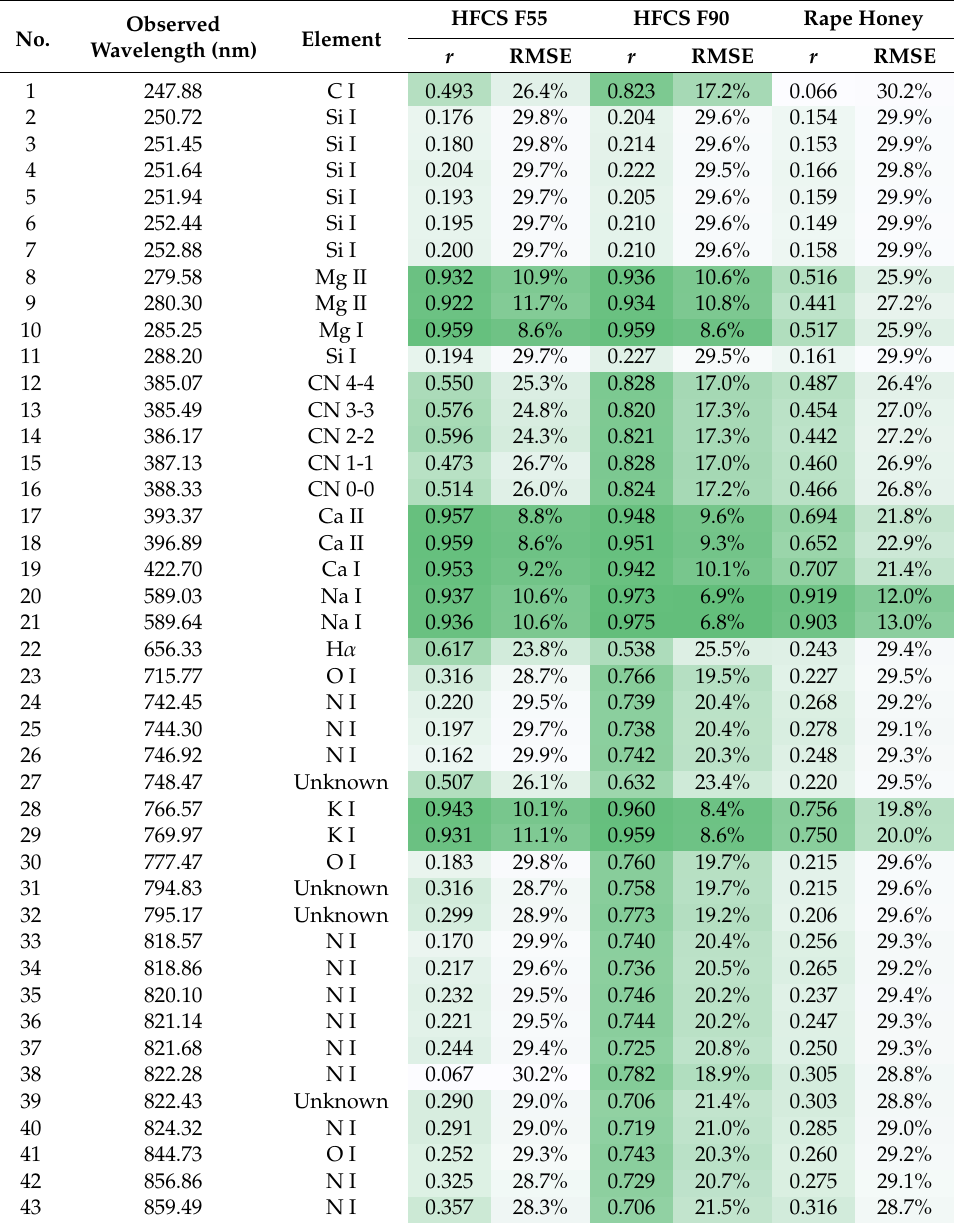
Table 1. Results of univariate analysis based on peak intensities of main